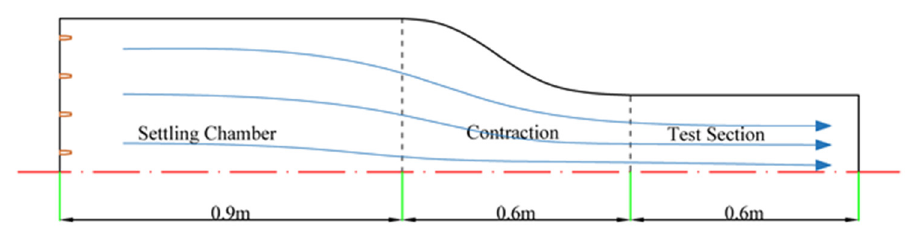
Figure 8. Schematic diagram of the length of each section.